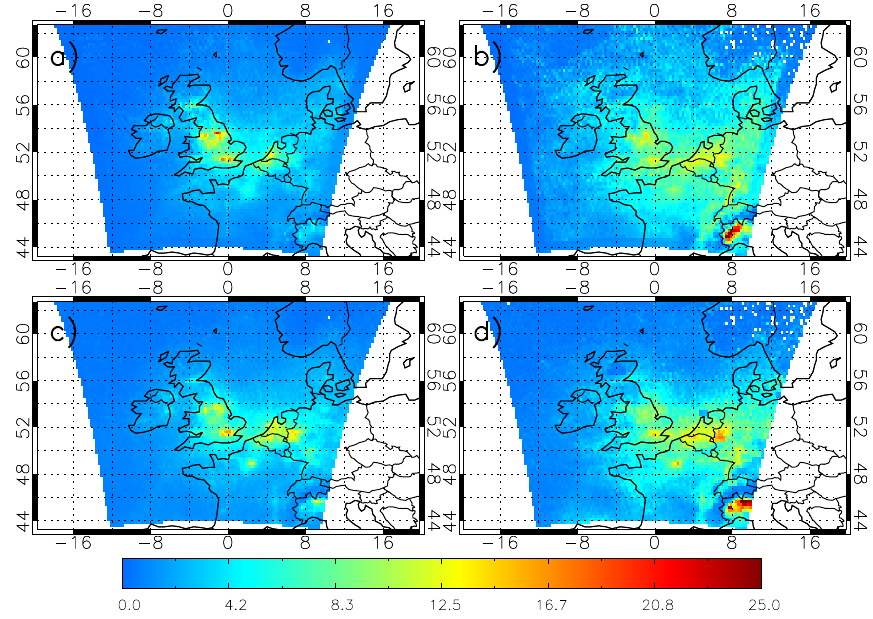
Figure 4. Tropospheric NO 2 column ( × 10 15 moleculescm − 2 ), 2006, for (a) AQUM Run C (with averaging kernels (AK) applied) summer,